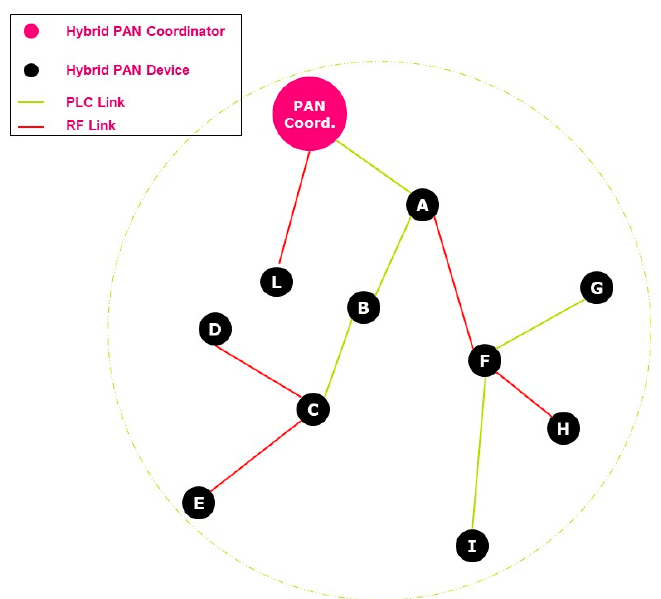
Figure 15. Typical hybrid network topology.